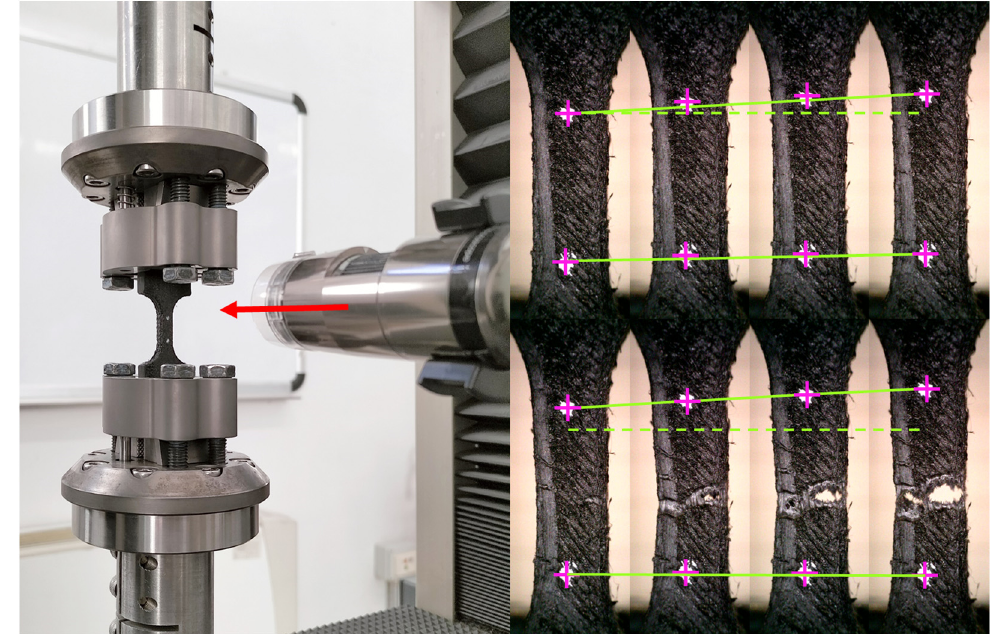
Figure 4. Experimental setup and scheme of the video tracking analysis.